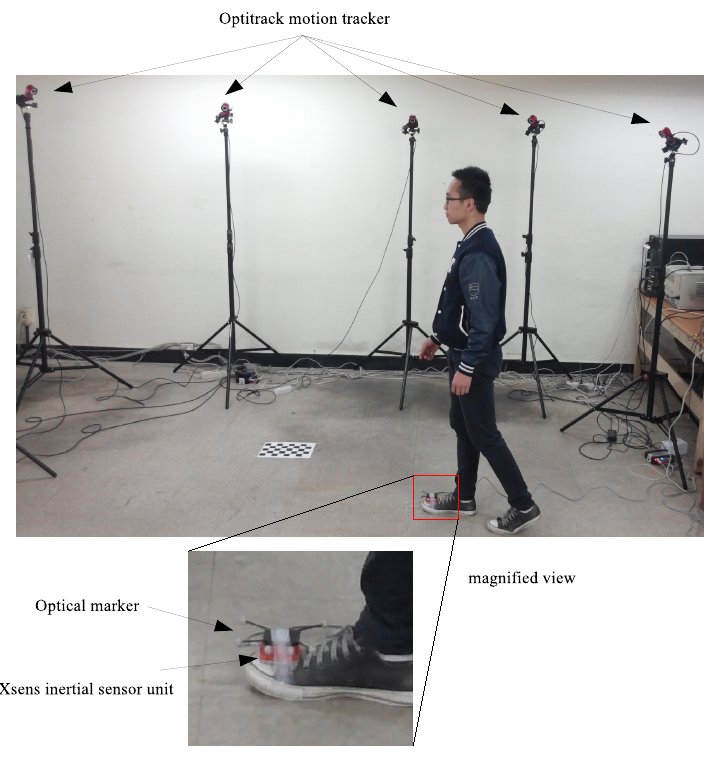
Figure 2. Experimental setup for the first experiment.